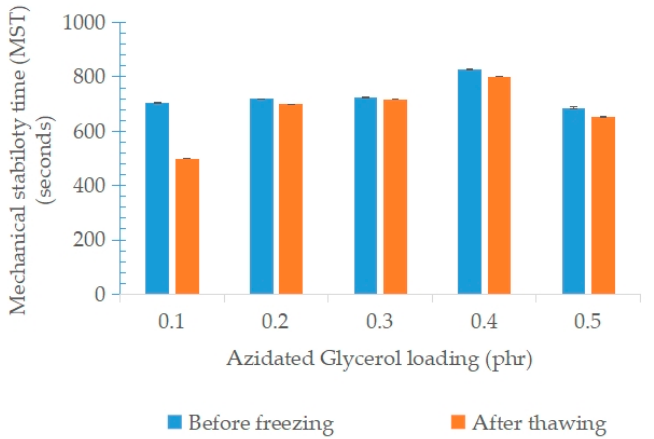
Figure 13. Mechanical stability time (MST) of NRL containing variable loadings of AG before freezing and after the freeze–thaw processes.